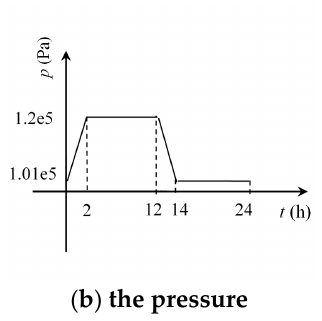
Figure 4. Numerical calculation model.